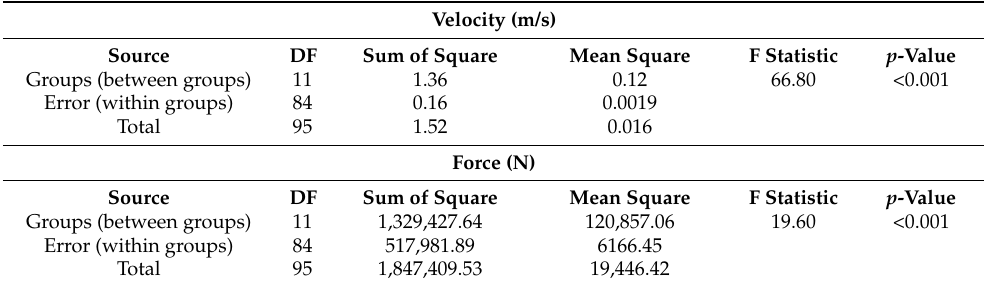
Table 3. ANOVA tables for velocity (m/s) and force (N) in the single pull-up test before the swim- ming competition.